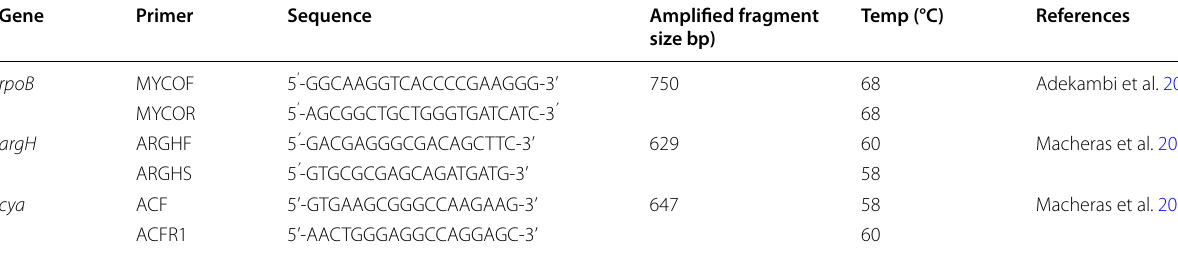
Table 1 Primer sequences used for PCR amplification and sequence analysis